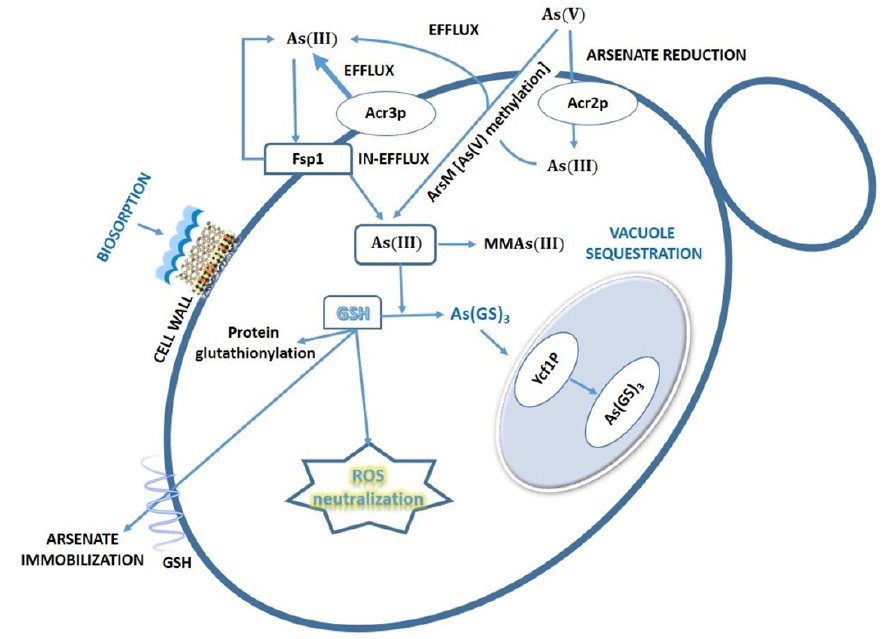
Figure 6. Uptake and resistance mechanisms to As in yeasts. MMAs(III): mononomethylarsonic acid. GSH: glutathione. As(GS) 3 : arsenic triglutathione .